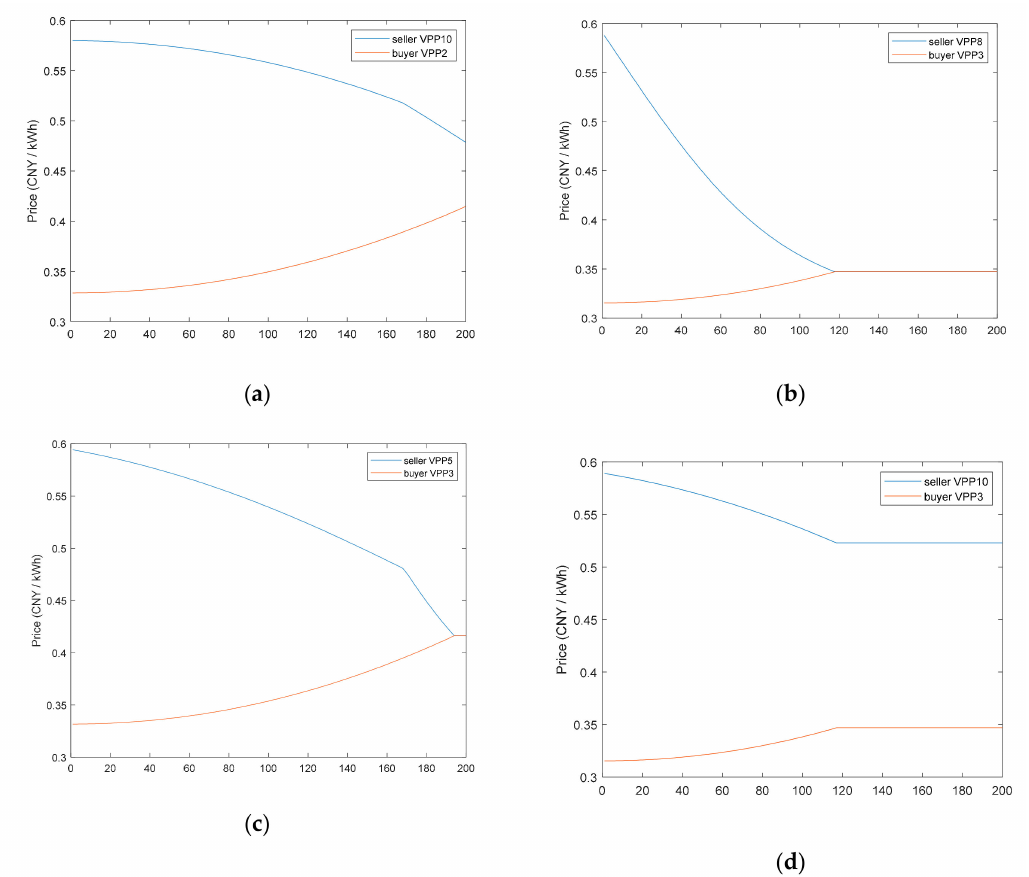
Figure 7. Price bidding process in the first round of P2P negotiation ( R = 1): ( a ) VPP 2 vs. VPP 10 , t = 1; ( b ) VPP 3 vs. VPP 8 , t = 2; ( c ) VPP 3 vs. VPP 5 , t = 1; ( d ) VPP 3 vs. VPP 10 , t =